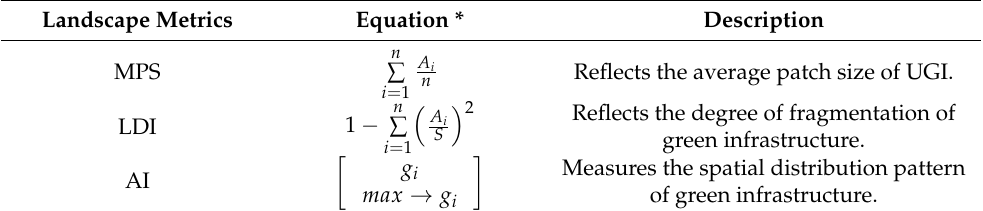
Table 2. List of landscape pattern metrics. Landscape